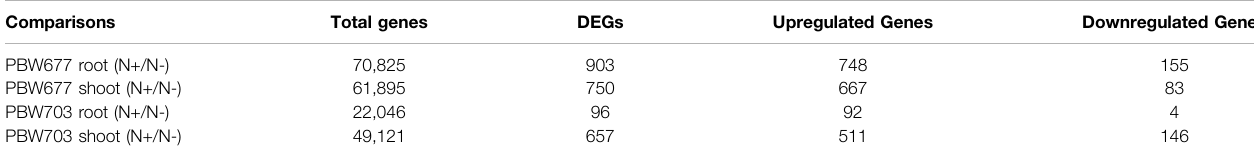
TABLE3| Totalnumberofdifferentiallyexpressedgenes(DEGs)andnumberofDEGs fi lteredonthebasislog2FC ≥ |2|andstatisticalsigni fi cance( p < 0.05)inshootandroot tissues of PBW677 and PBW703 between high (N+)/low (N-) levels.